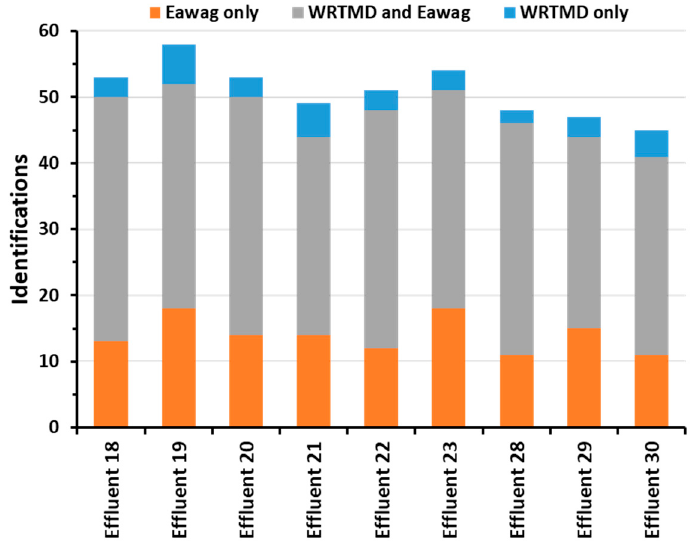
Figure 4. Application of the two tandem mass spectral libraries to the analysis of wastewater samples collected at the effluent of nine Swiss WWTP. The target and nontargeted LC-MS/MS data was acquired on an Orbitrap instrument using DDA. The column chart visualises the number of identifications obtained with the WRTMD and/or the Eawag library for each sample analyzed.